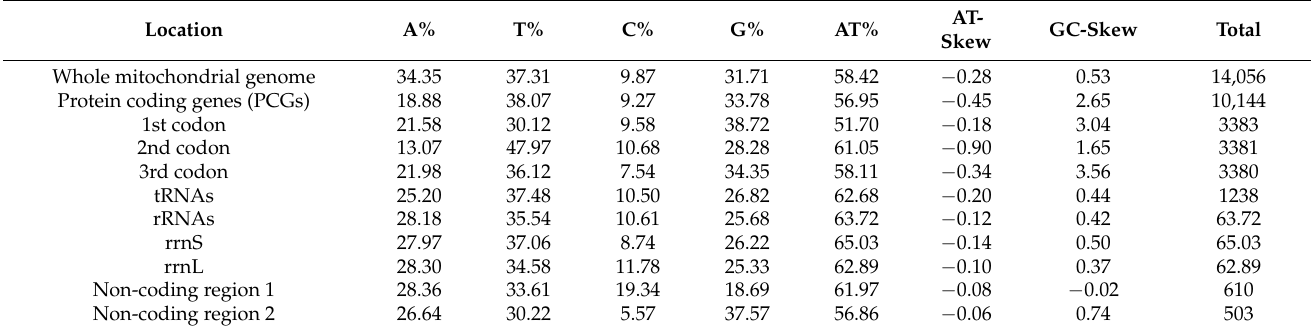
Table 5. Base composition and skewness of Pseudoacanthocephalus bufonis .